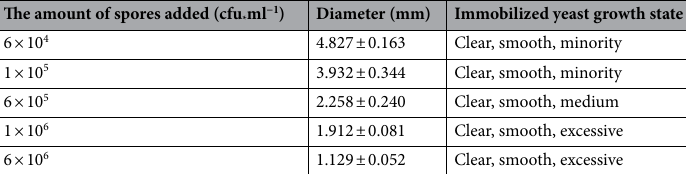
Table 5. Effect of the amount of spores of P. chrysogenum on immobilized yeast.